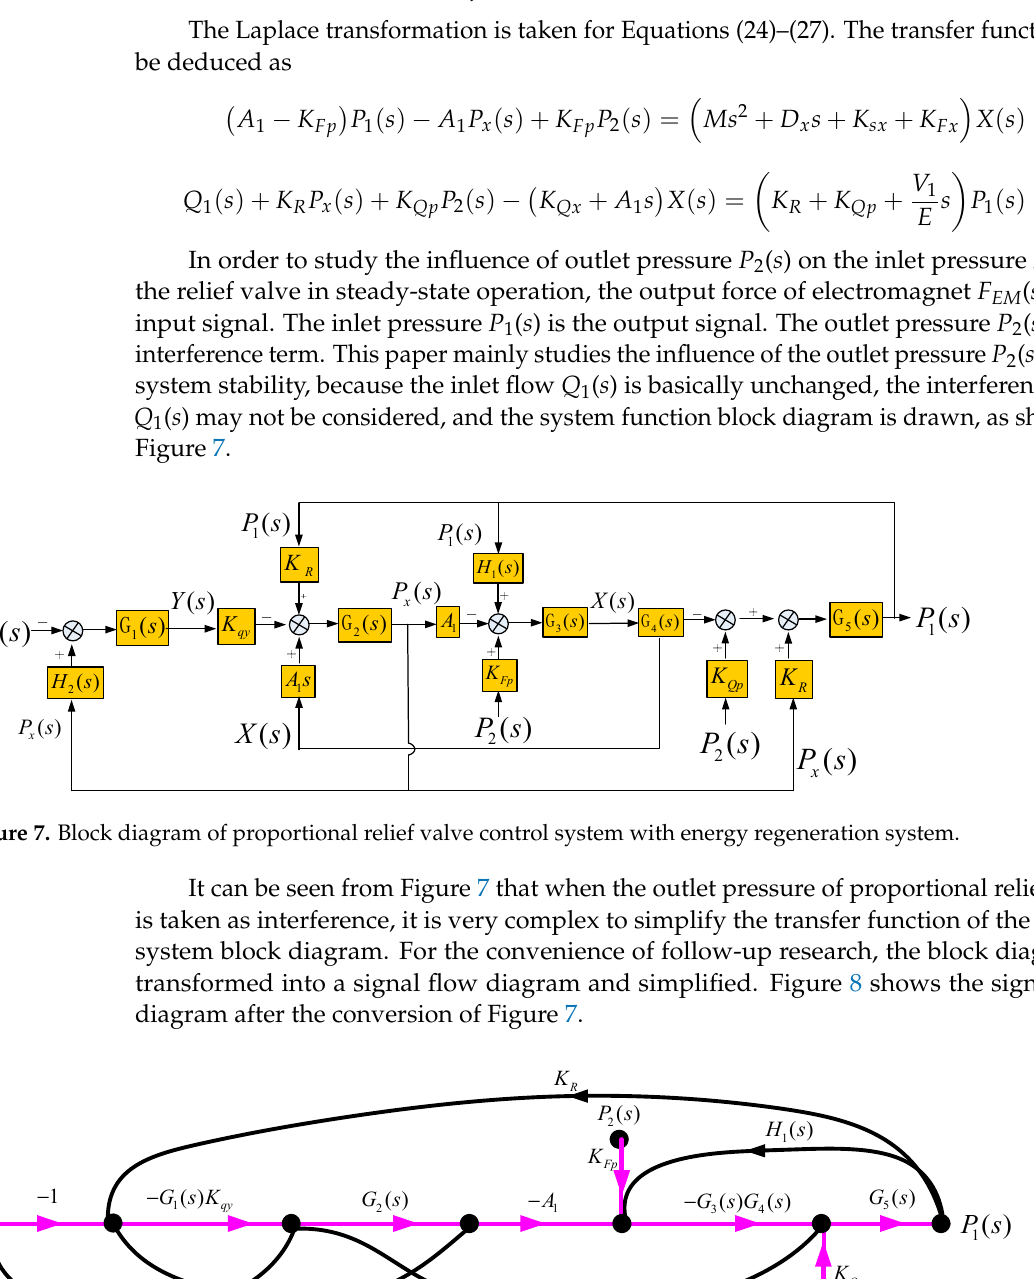
Figure 9. Signal flow diagram of the traditional proportional relief valve control system. 3.3. Stability Analysis of Outlet Back Pressure System of Proportional Relief Valve The closed-loop transfer functions from input variables F EM ( s ) and disturbances P 2 ( s ) to output variables P 1 ( s ) can be obtained by the Mason formula [23]. The Mason formula can be expressed as 1 1 n k k k M P = = Δ Δ  (30) According to Figure 9, the transfer function of the electromagnet output force F EM ( s ) of the traditional proportional relief valve to the inlet pressure can be deduced as 2 1